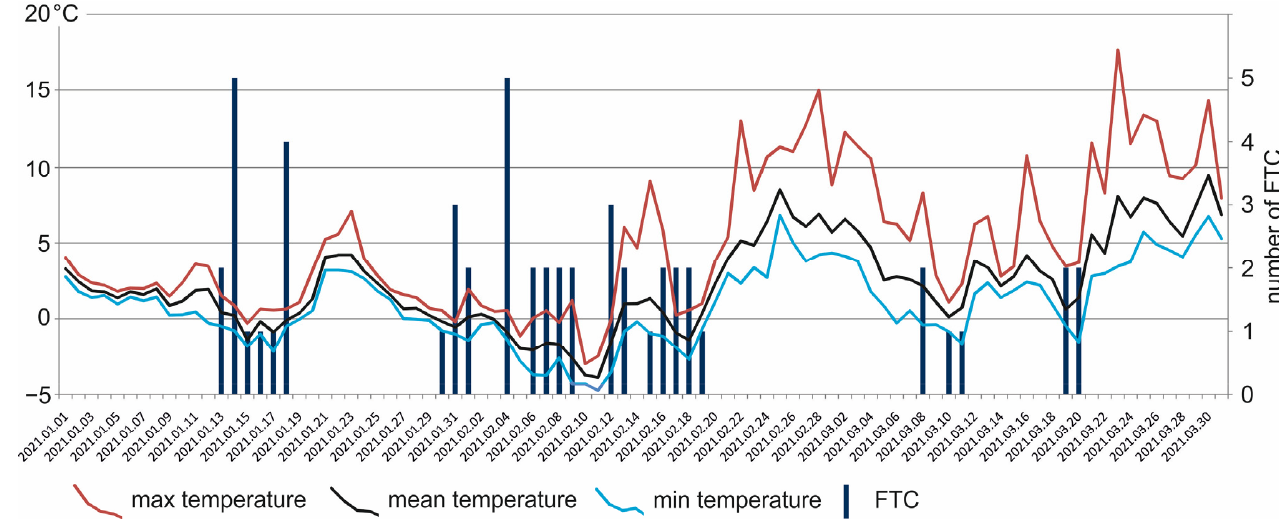
Figure 10. Air temperature and number of FTC in the winter season of 2020/2021.